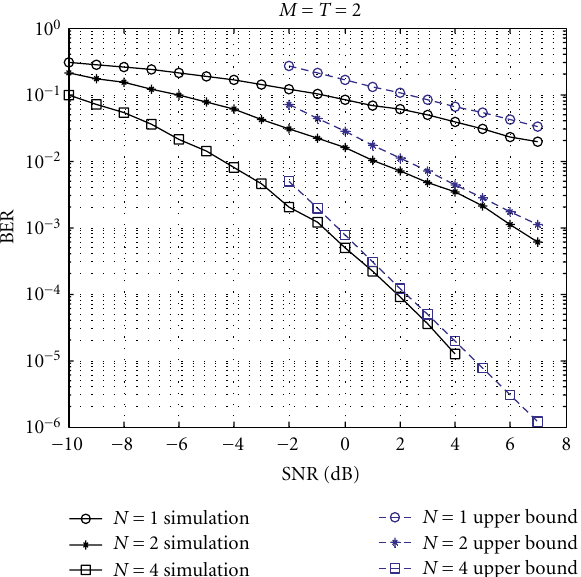
Figure 1: BER performance of USTC-UWB and its upper bound.